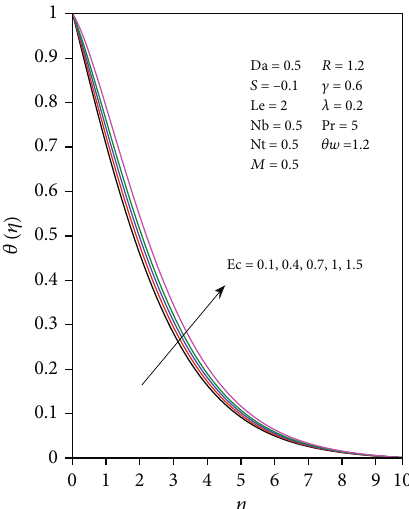
Figure 7: Temperature pro fi le for di ff erent values of Pr